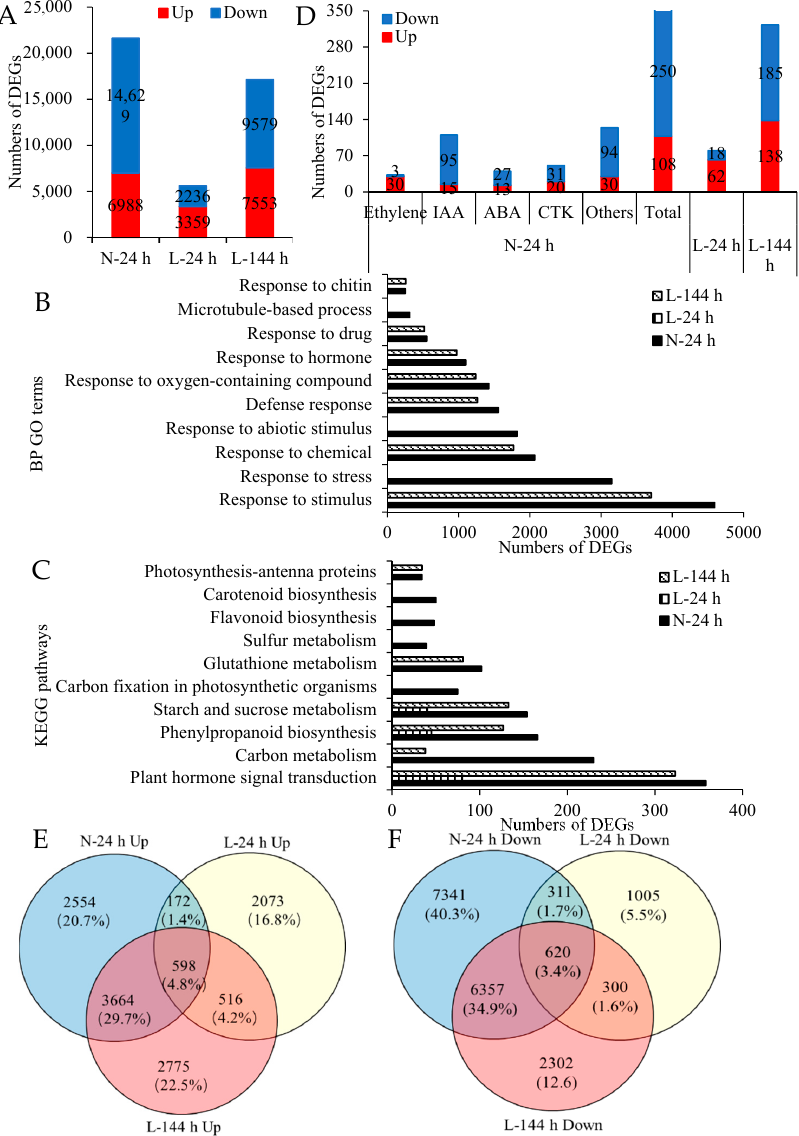
Figure 2. DEGs induced by TDZ (TDZ vs. control) in cotton AZs under different temperatures. ( A ) The numbers of DEGs in cotton AZs induced by TDZ. N-24 h, 24 h after treatment at normal temperature (25 ◦ C). L-24 and L-144 h, 24 and 144 h, respectively, after treatment at low temperature (15 ◦ C). The DEGs are controlled by q -value < 0.05 and |log 2 FC| ≥ 1. FC represents the expression-level fold change of genes. Black digits indicate the gene numbers; ( B ) enriched biological process GO terms (FDR (false discovery rate) < 0.001,). X -axis shows numbers of DEGs and Y -axis shows the top ten enriched GO terms of DEGs induced by TDZ at N-24 h; ( C ) enriched KEGG pathways (FDR < 0.05). X -axis shows numbers of DEGs and Y -axis shows the top-ten enriched KEGG pathways of DEGs induced by TDZ at N-24 h; ( D ) the numbers of plant signaling genes in cotton AZs regulated by TDZ; ( E , F ) Venn diagram displaying the number of DEGs unique to each time point or overlapping between different time points in AZs treated with TDZ compared with control. Upregulated DEGs ( E ). Downregulated DEGs ( F ). Black digits indicate the gene numbers. The percentage shows the proportion of DEGs of each part in all DEGs at three time points.